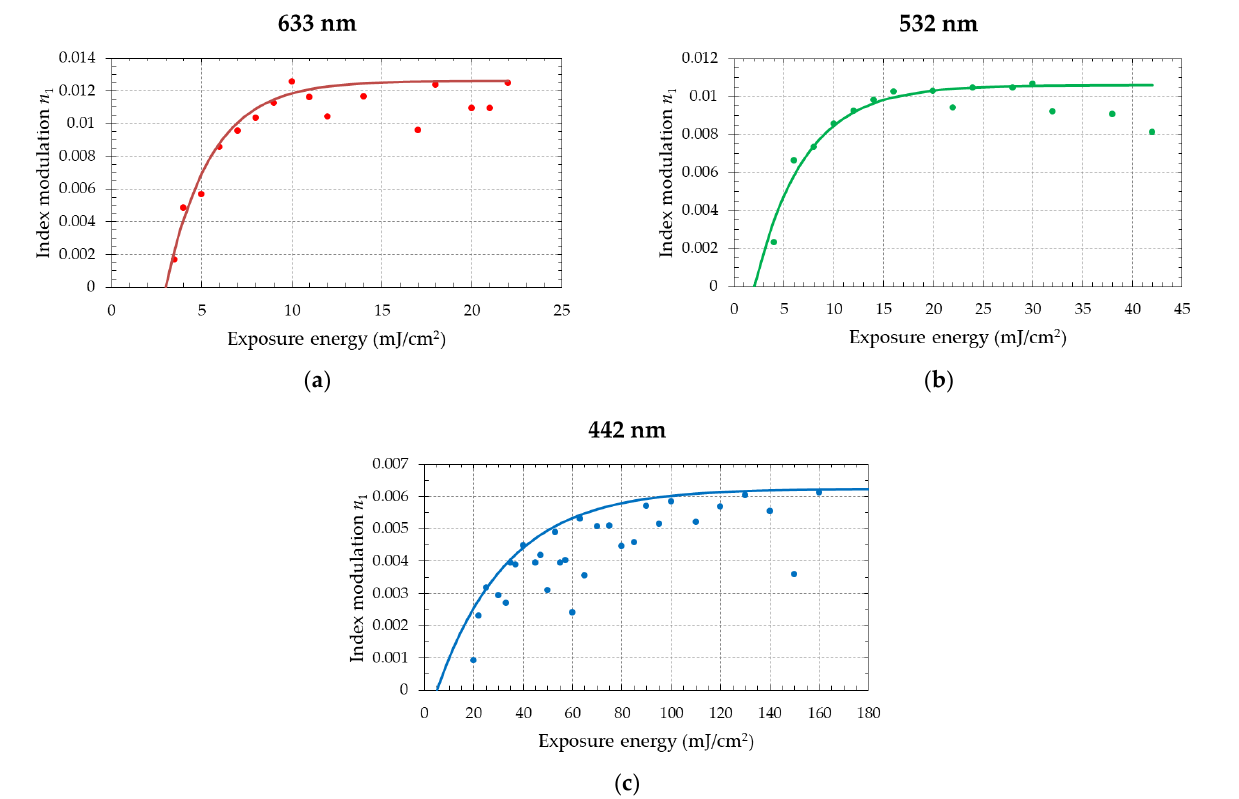
Figure 6. Index modulation with respect to the exposure in the recording with each of the three wavelengths ( a ) 633 nm (red) ( b ) 532 nm (green) and ( c ) 422 nm (blue). Table 2. Maximum modulation values of the refractive index for an ideal efficiency of 100% and that obtained experimentally.